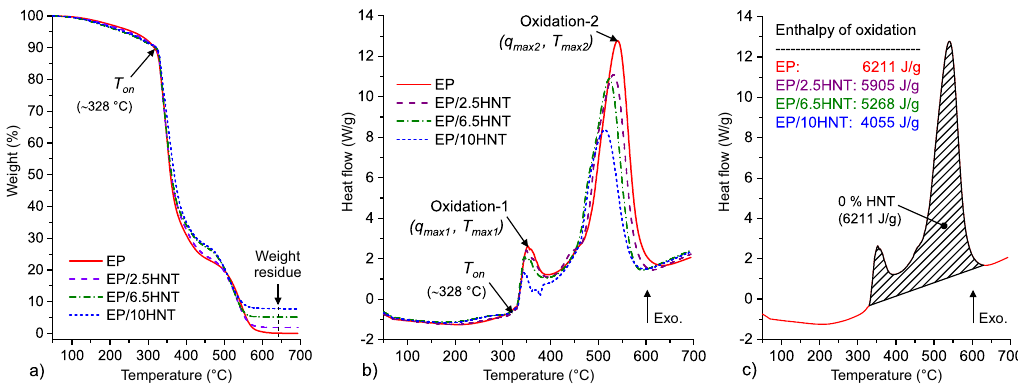
Figure 3. Graphical summary of the simultaneous thermal analysis (STA) results: ( a ) Weight changes (thermogravimetry (TG) curves), ( b ) heat flow changes (differential scanning calorimetry (DSC)